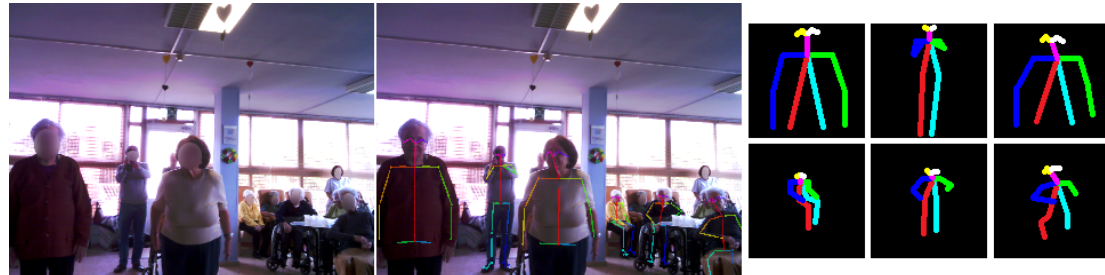
Figure 2. Human representation in terms of limbs by using Openpose: ( left ) Original image taken by the Pepper robot; ( middle ) Openpose output as body keypoint coordinates; ( right ) The human skeleton colour-coded to properly distinguish each limb (one per person).